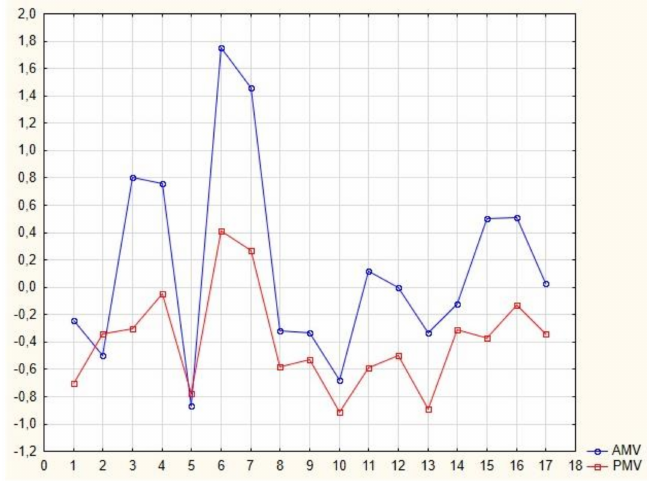
Figure 3. Comparison between AMV and PMV.